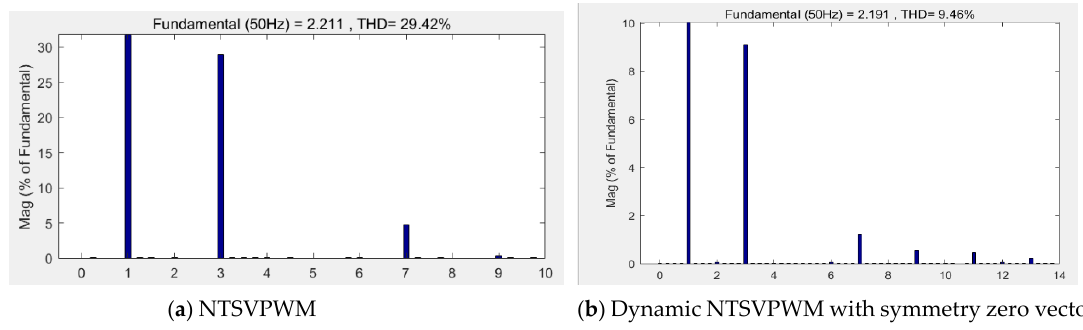
Figure 28. Voltage waveform based on traditional modulation at m = 1.1.